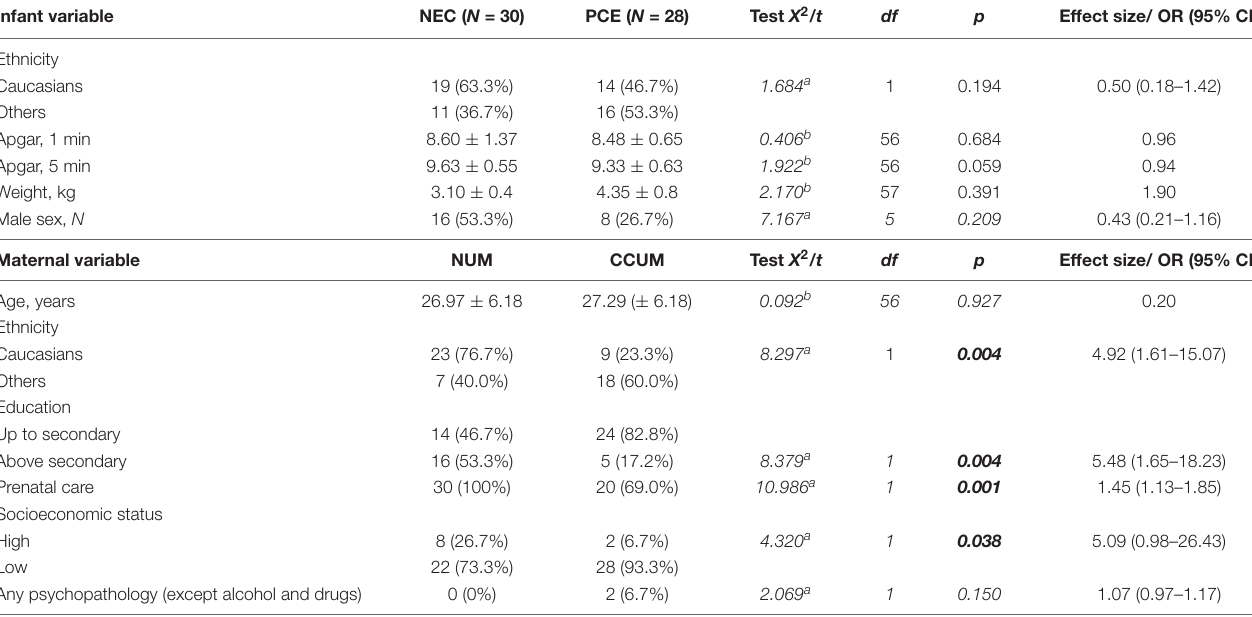
TABLE 1 | Sociodemographic and clinical characteristics of pregnant crack cocaine users and their newborns in comparison to a control